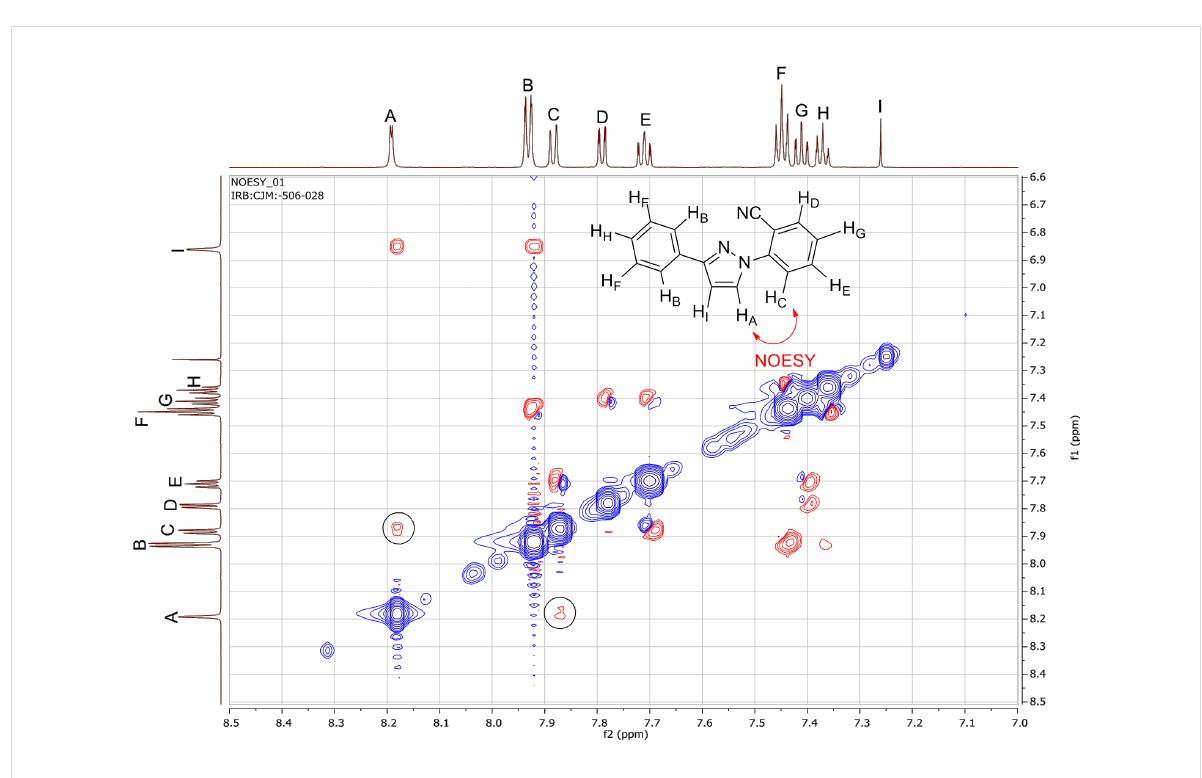
Figure 6: NOESY NMR spectrum for 35 with the characteristic NOESY signal